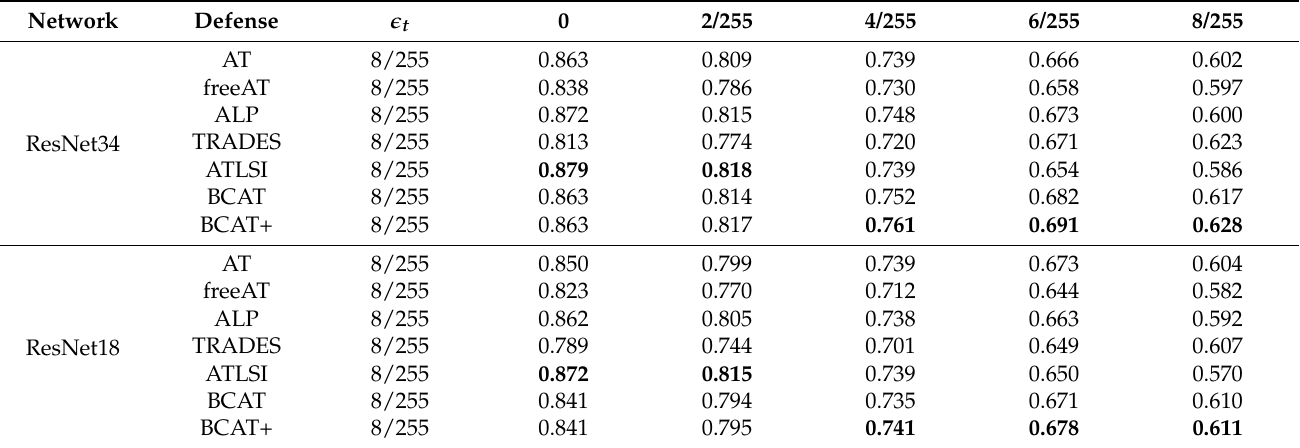
Table 1. Comparing the white-box adversarial robustness generalization accuracy of different defense methods on